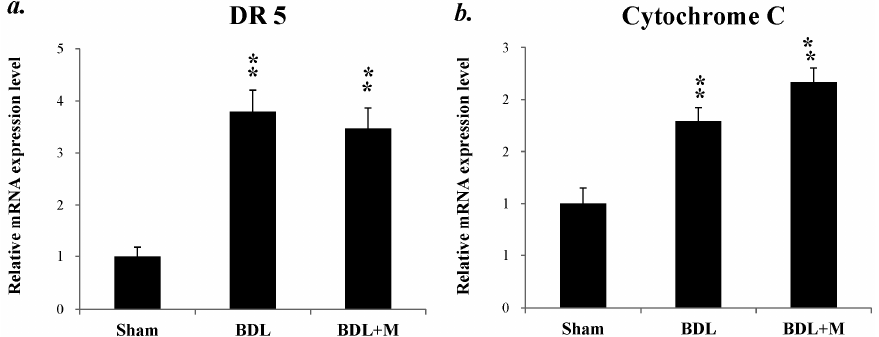
Figure 7. ( a ) BDL and melatonin treatment induced the up-regulation of TNF-Related Apoptosis-Inducing Ligand Receptor 2/death receptor 5 (TRAIL-R2/DR 5) and melatonin treatment showed no effect on it; ( b ) BDL increased cytochrome c mRNA expression and melatonin treatment showed no effect on it. Significant difference among three groups was analyzed by one-way ANOVA followed by Bonferroni post hoc. All data are shown as mean ± SEM. ** p < 0.01 vs. BDL.